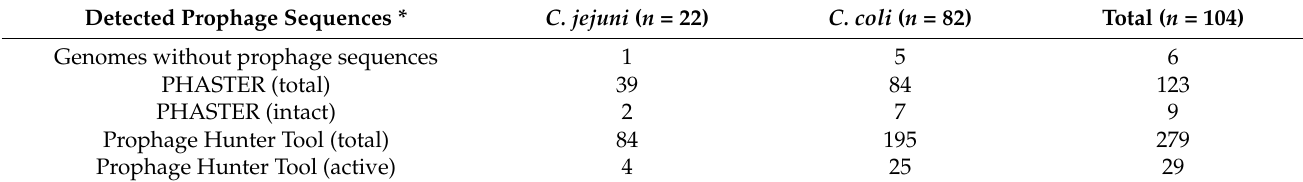
Table 1. Number of predicted prophage regions within newly sequenced C. coli and C. jejuni genomes using PHASTER [21] and Prophage Hunter